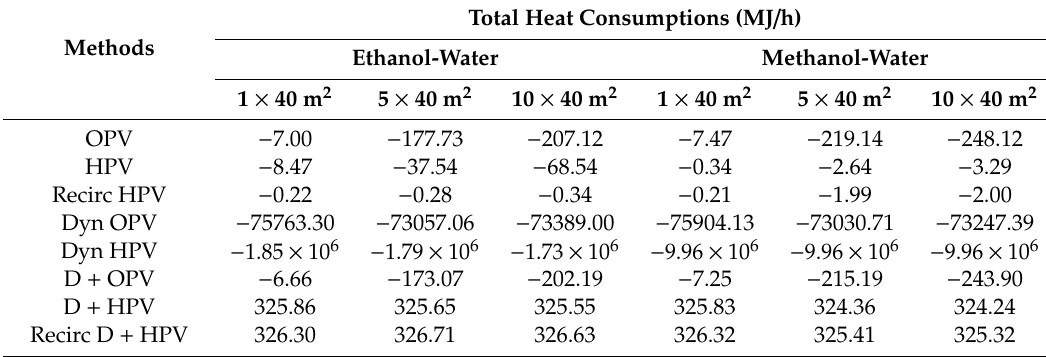
Table 9. Total heat consumptions of ethanol-water and methanol-water methods.